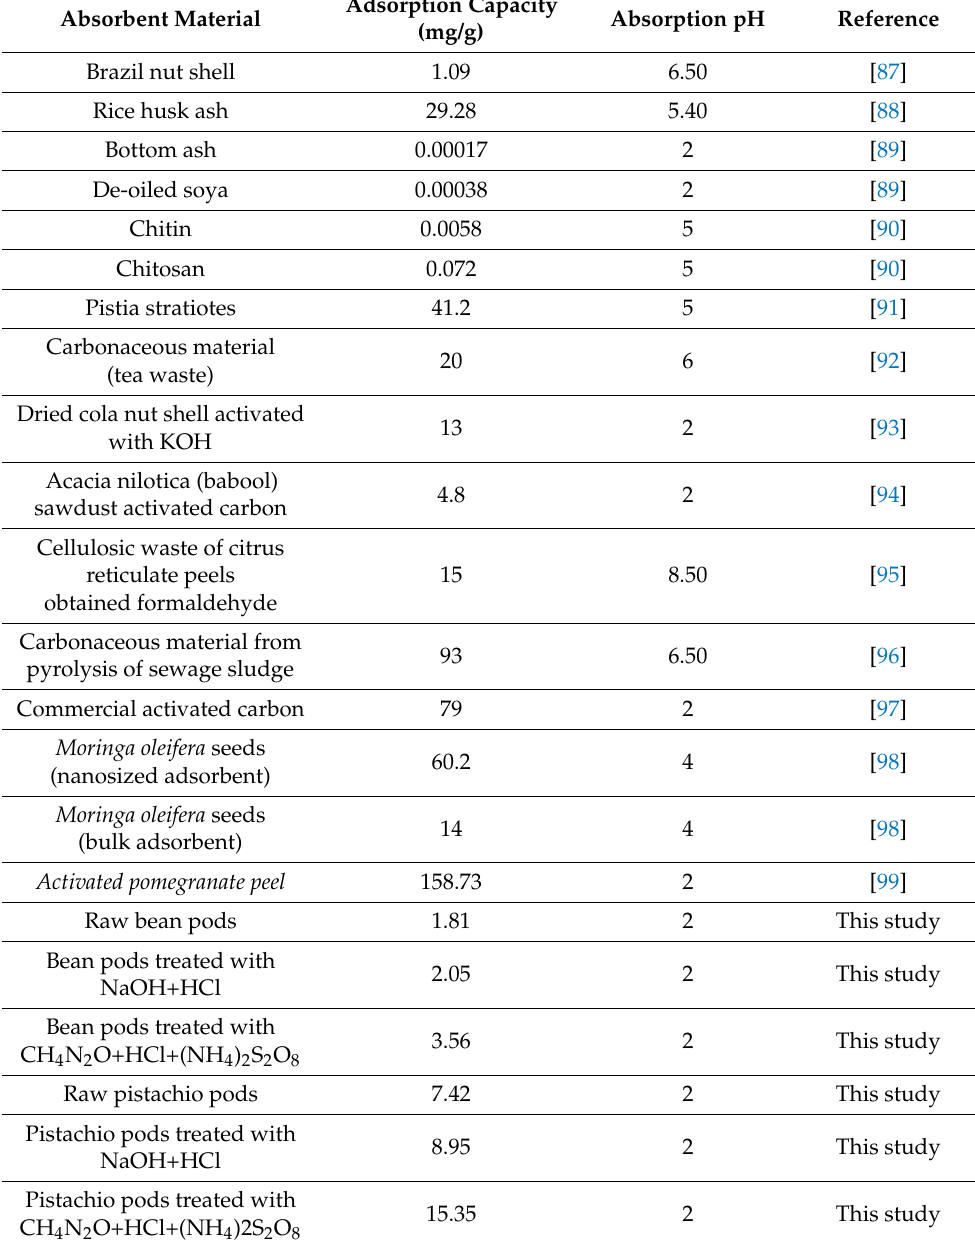
Table 9. Adsorption amounts of IC onto some adsorbent